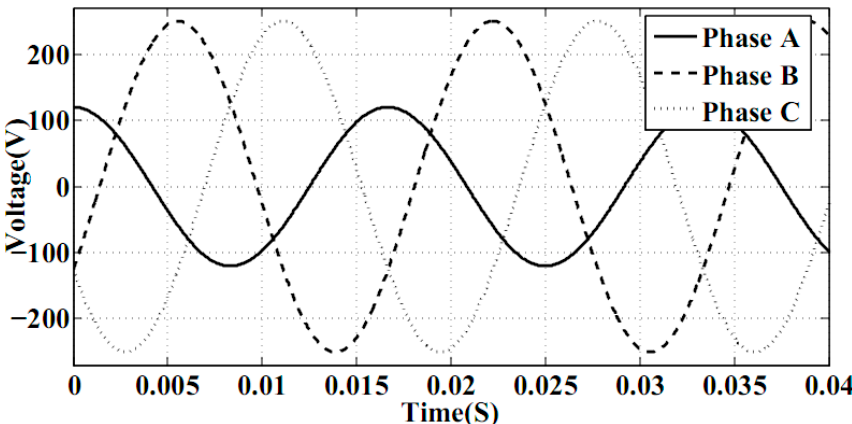
Figure 14. Unbalanced three-phase voltage source.